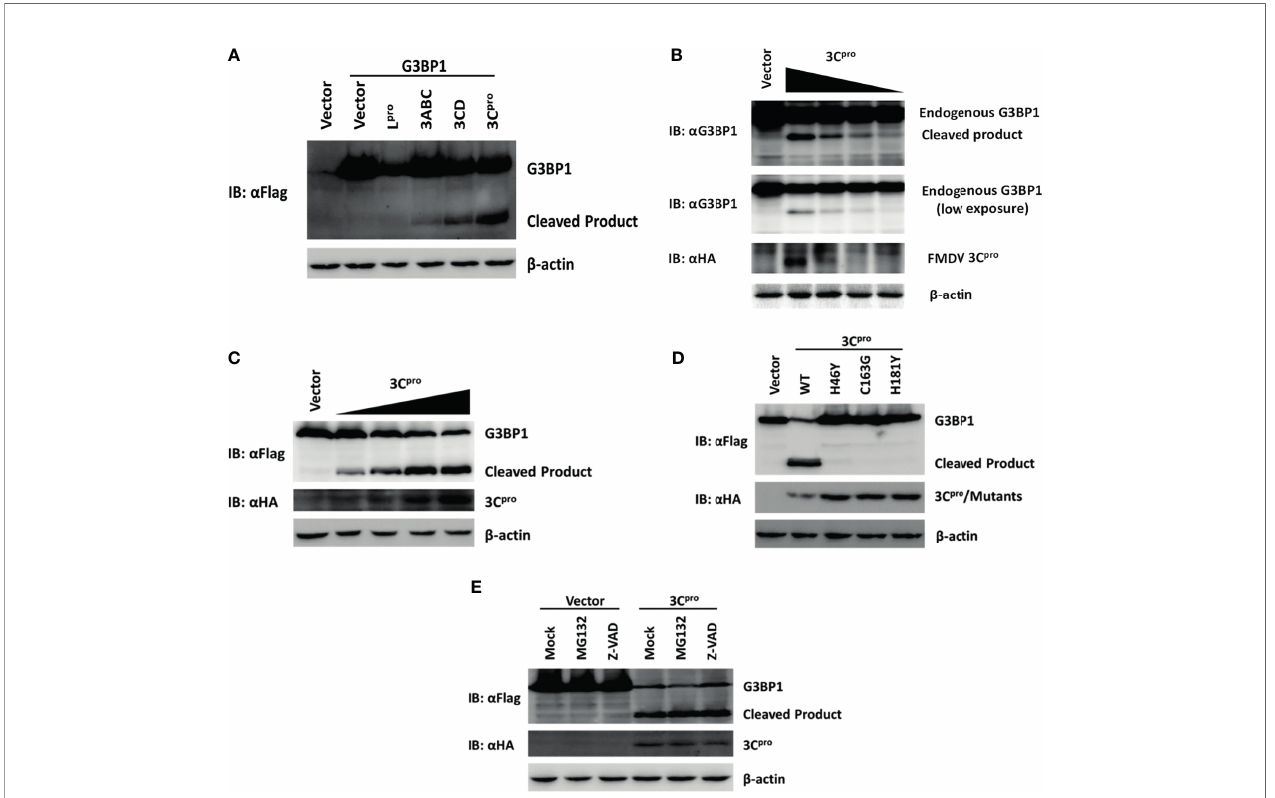
FIGURE 6 | Foot-and-mouth disease virus 3C pro cleaves G3BP1 by means of its protease activity. (A) Human embryonic kidney cells (HEK)-293T cells cultured in 60-mm dishes were transfected with Flag-tagged porcine G3BP1 as indicated (4 m g), along with HA-L pro , 3C pro , or 3C pro -containing precursors (0.05 m g). Cell lysates were prepared 30 h post-transfection and analyzed by western blotting. (B) IBRS-2 cells were transfected with increasing quantities (0, 0.5, 1, 2, or 4 m g) of plasmid encoding 3C pro . Cell lysates were prepared 36 h post-transfection and analyzed by western blotting. (C) HEK-293T cells were transfected with Flag-tagged wild-type porcine G3BP1 (4 m g), along with increasing quantities HA-3C pro plasmid (0, 0.0125, 0.025, 0.05, or 0.1 m g). Cell lysates were prepared 30 h post- transfection and analyzed by western blotting. (D) HEK-293T cells were transfected with Flag-tagged porcine G3BP1 expression plasmid (4 m g), along with wild-type 3C pro expression plasmids or its mutants (0.05 m g). Cell lysates were prepared 30 h post-transfection and analyzed by western blotting. (E) HEK-293T cells were co- transfected with Flag-tagged porcine G3BP1 expression plasmid (4 m g) and plasmid encoding 3C pro or empty vector (0.05 m g). 24 h after transfection, MG132 or zVAD-FMK were added to a fi nal concentration of 20 m M. Cell lysates were prepared 8 h after treatment and analyzed by western